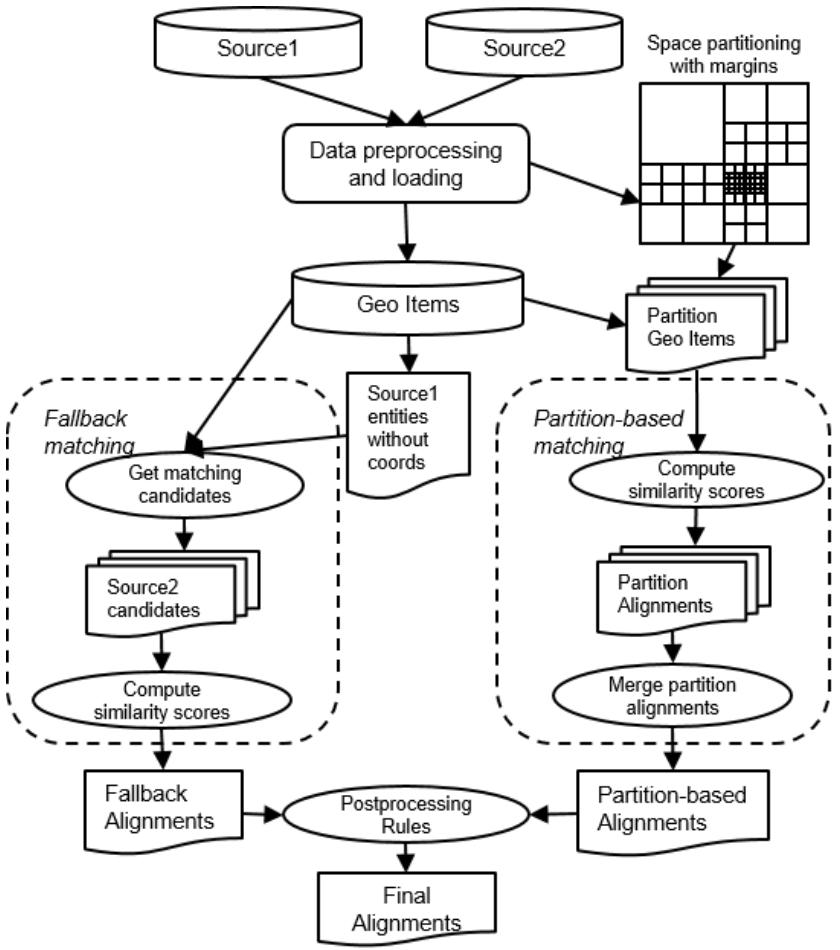
Figure 3. Architecture of GLEAN in offline matching